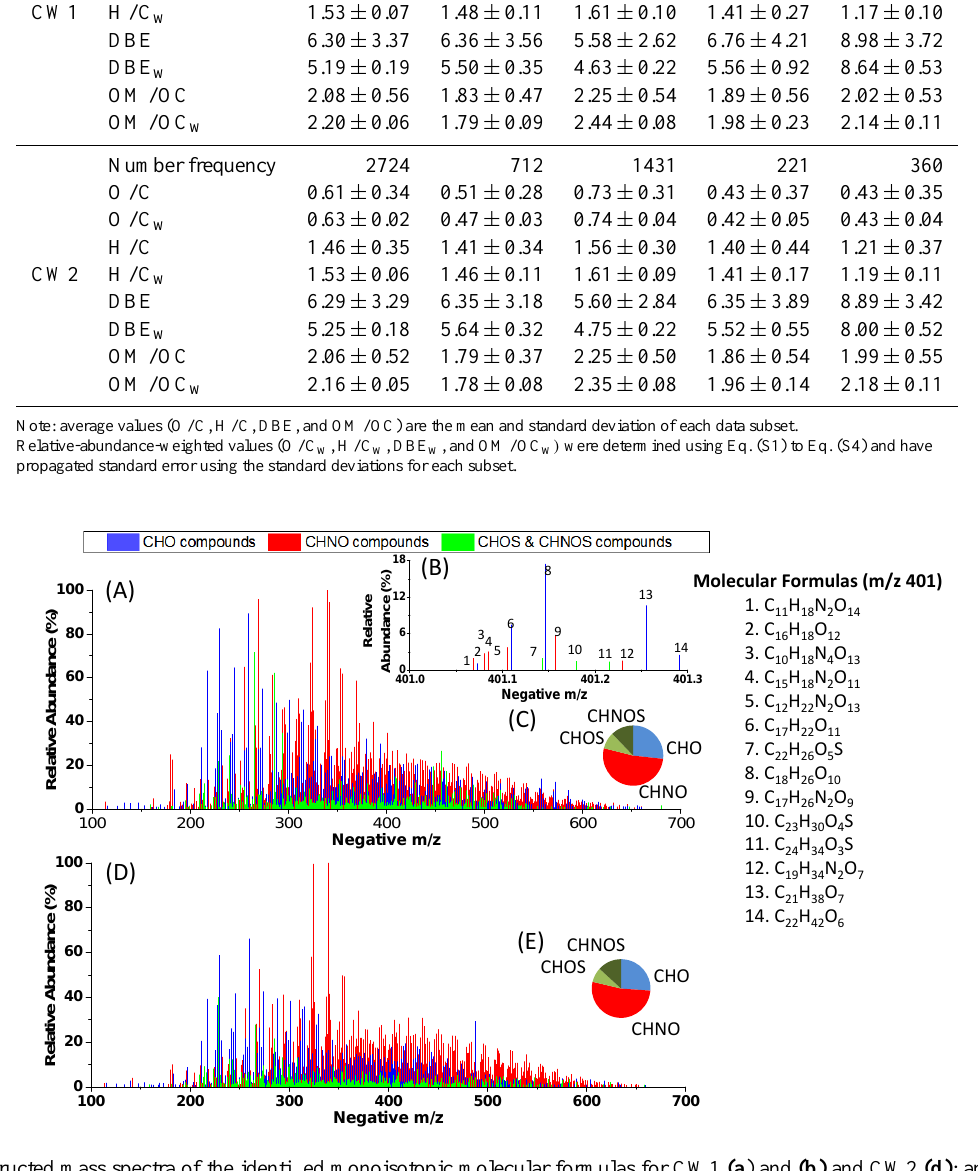
region include the homologous series of C 20 H 8 O 4 (CH 2 ) 1 − 7 and C 19 H 6 O 5 (CH 2 ) 1 − 6 . The average O / C ratios for the CW1 and CW2 CHO compounds are 0.54 ( ± 0.35) and